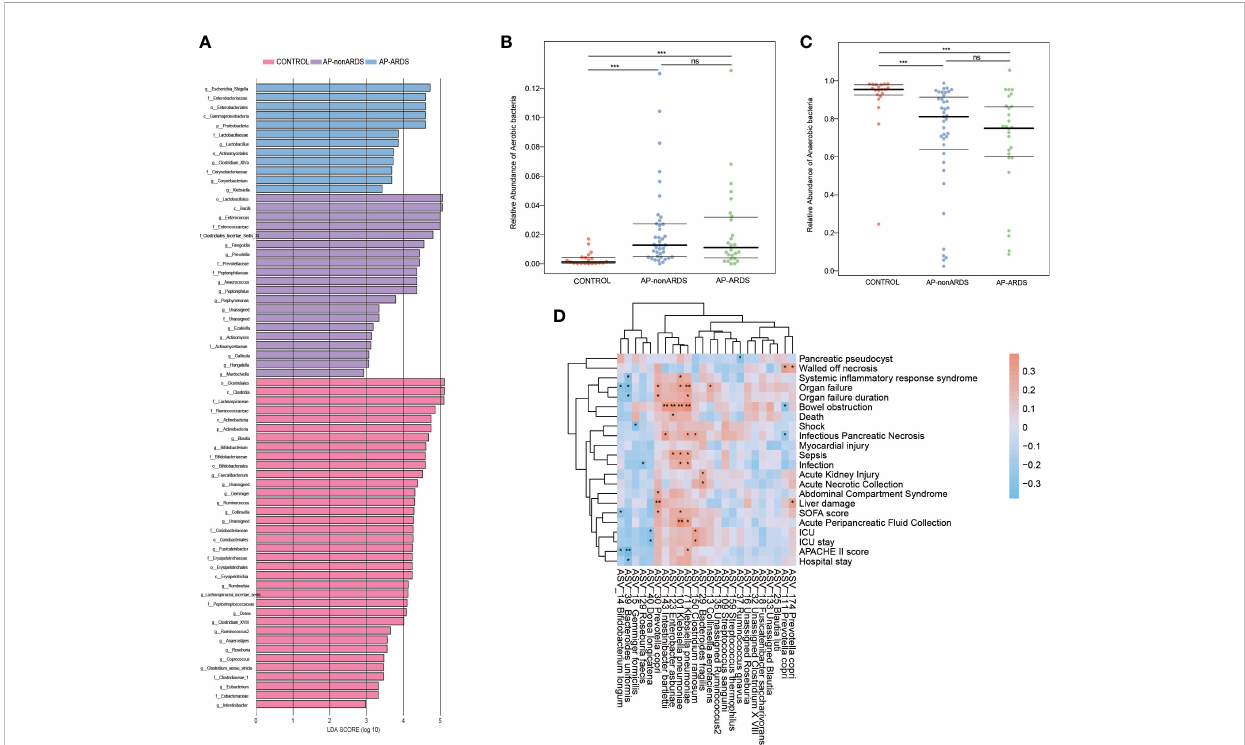
FIGURE 4 Microbial Function Analysis and Clinical Correlation Analysis. (A) . Linear discriminant analysis (LDA) Effect Size (LEfSe) analysis. (B) . Relative abundance of aerobic bacteria in BugBase analysis. (C) . Relative abundance of anaerobic bacteria in BugBase analysis. (D) . Spearman correlation of clinical characteristics and different species between AP-ARDS and AP-nonARDS group. * P < 0.05; *** P < 0.001, ns: not signi fi